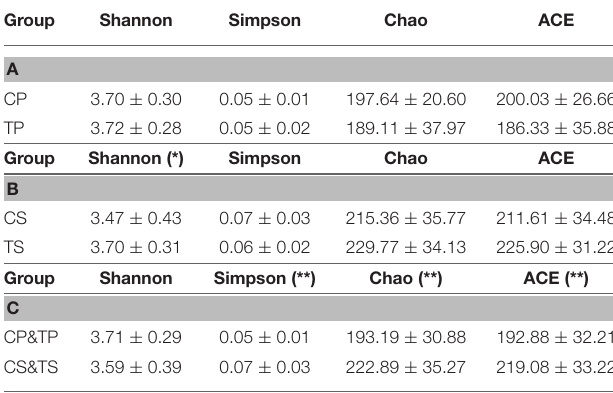
TABLE 1 | Alpha diversity indices of different